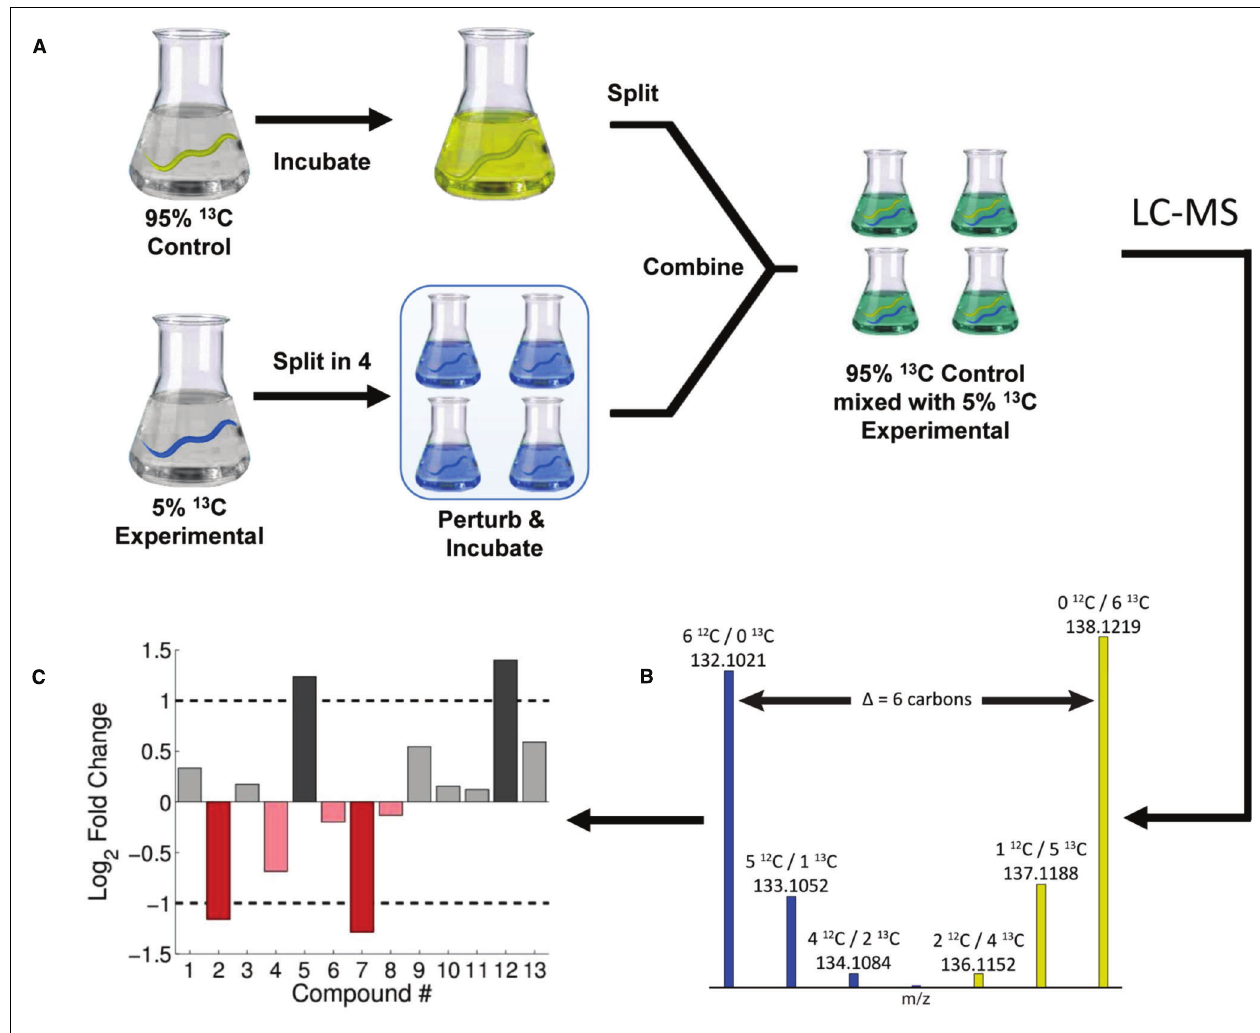
FIGURE 1 | Summary of IROA methods using C. elegans . Control and experimental populations of C. elegans were grown on 95 and 5% 13 C labeled bacteria, respectively (A) . The experimental population were split prior to perturbation and then combined with